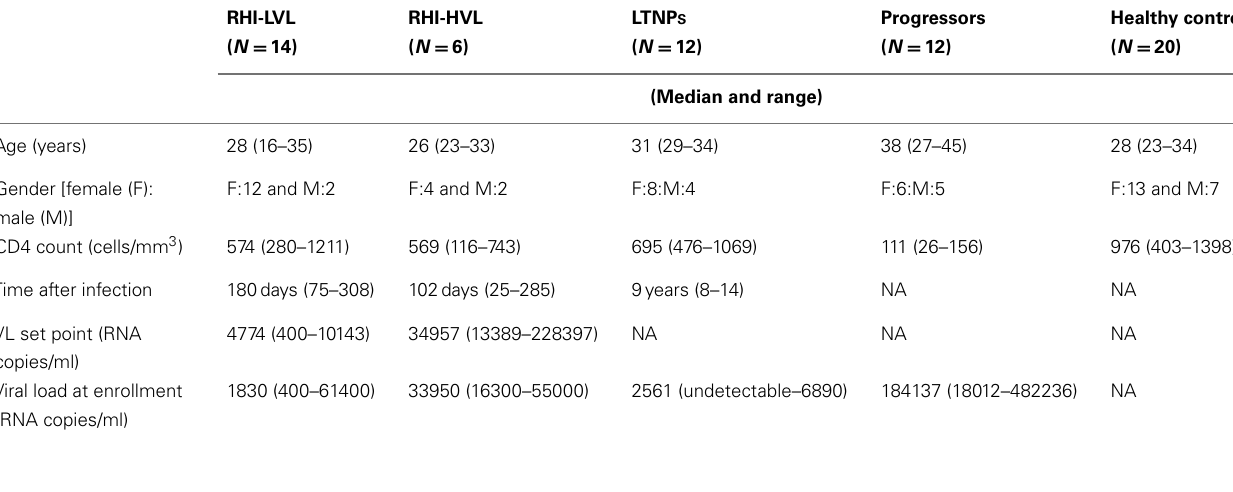
Table 1 | Demographic, virological, and immunological characterization of study participants